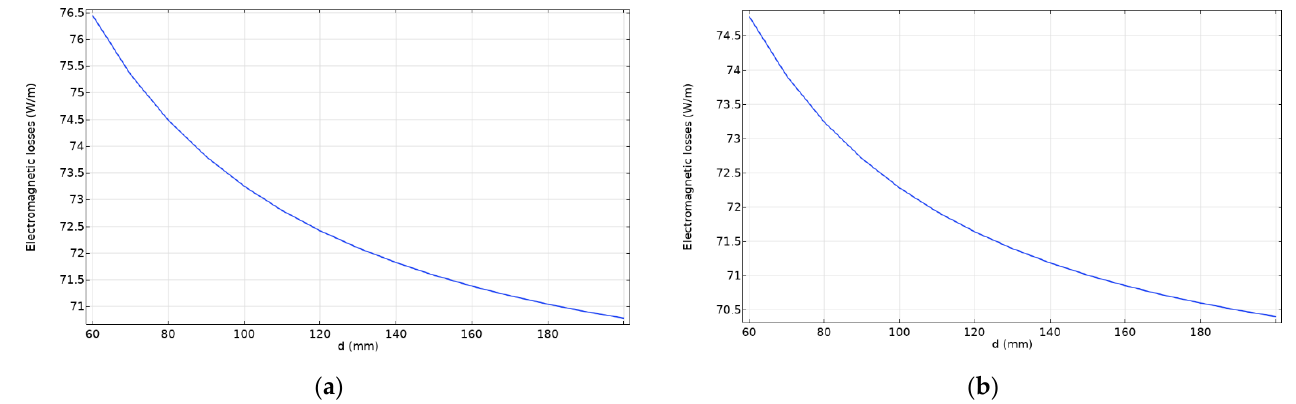
Figure 4. Electromagnetic heating against the phase-to-phase distance at 60 Hz for: ( a ) Model 1; ( b ) Model 2.